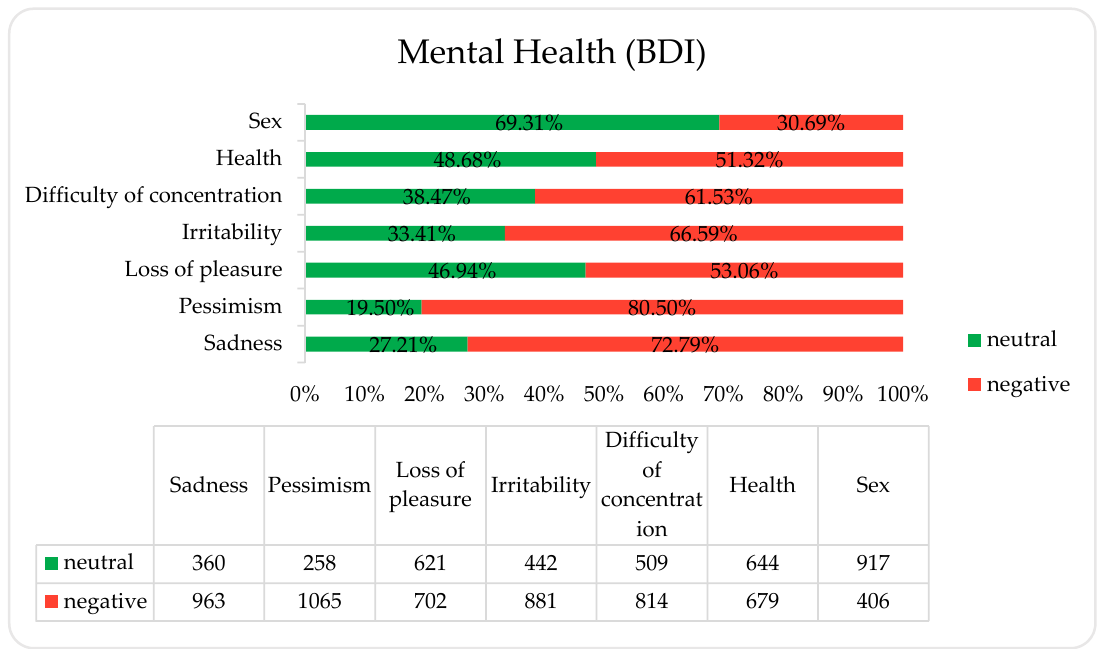
Figure 5. Answers to seven questions from the Beck Depression Inventory (BDI) divided into neutral and negative categories.